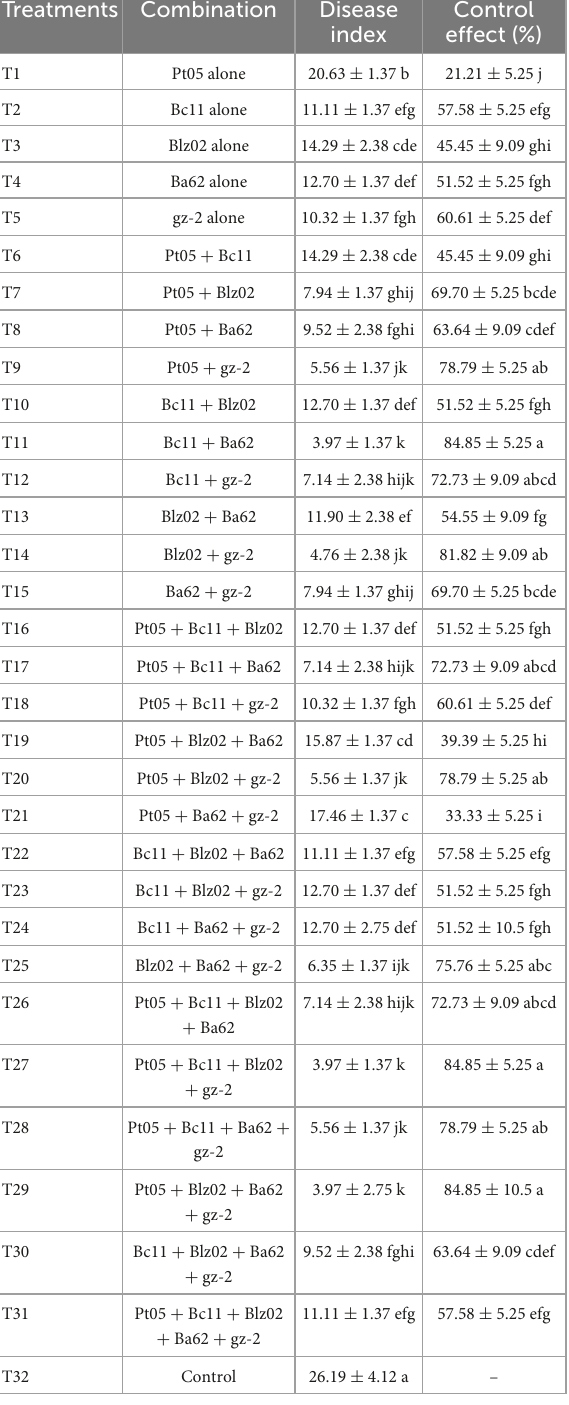
TABLE 4 Disease index of banana seedlings and control effect of biocontrol strains against Fusarium wilt of banana. Treatments